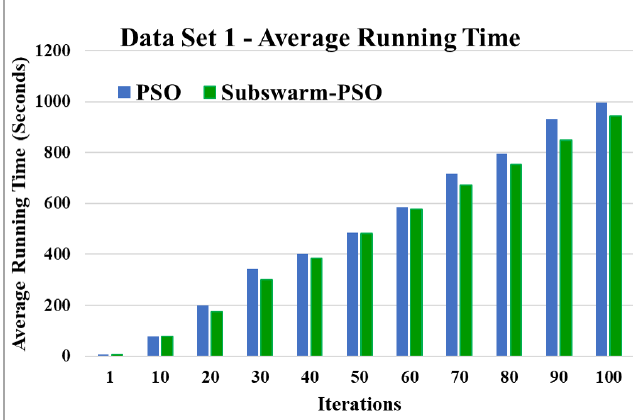
Figure 6. Average running time for data set